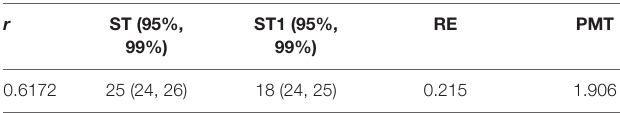
TABLE 2 | Statistical test parameters of the reconstructed SCE 3 − 5 on the